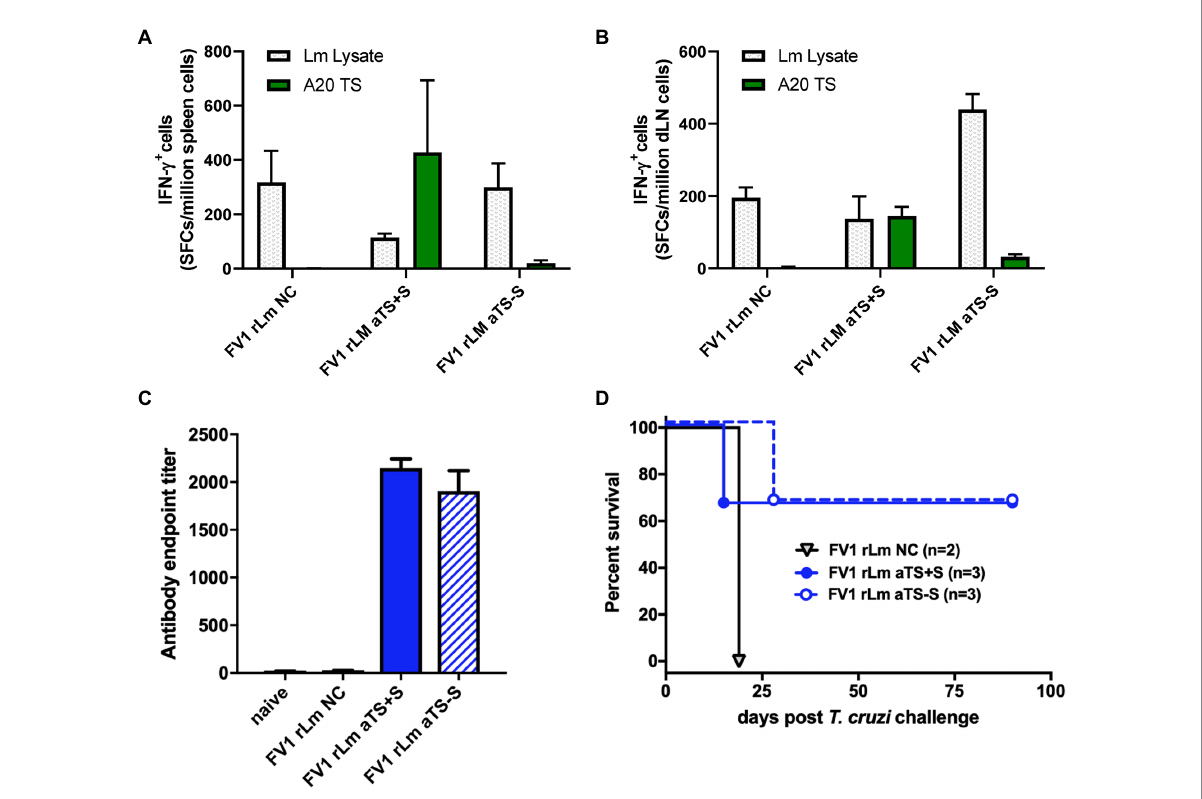
FIGURE 3 Recombinant TS-expressing FV1 L. major parasites induce T cell and antibody responses protective against T. cruzi challenge. Mice were inoculated by footpad injection with 1,000 FV1 L. major parasites transfected with a control vector (NC), active secreted TS (aTS+S), or active nonsecreted TS (aTS − S). TS-specific IFN- γ responses were detected by ELISPOT assay among spleen cells (A) and lymph node cells (B) from mice vaccinated with FV1 r Lm aTS+S compared to NC, and to a lesser extent from mice vaccinated with FV1 r Lm aTS − S. Mice inoculated with FV1 parasites expressing either secreted or non-secreted forms of active TS protein had significantly higher TS-specific antibody titers measured by ELISA compared to control (C) , and some mice survived a normally fatal challenge (D) . NC A20 - negative control antigen presenting cells;